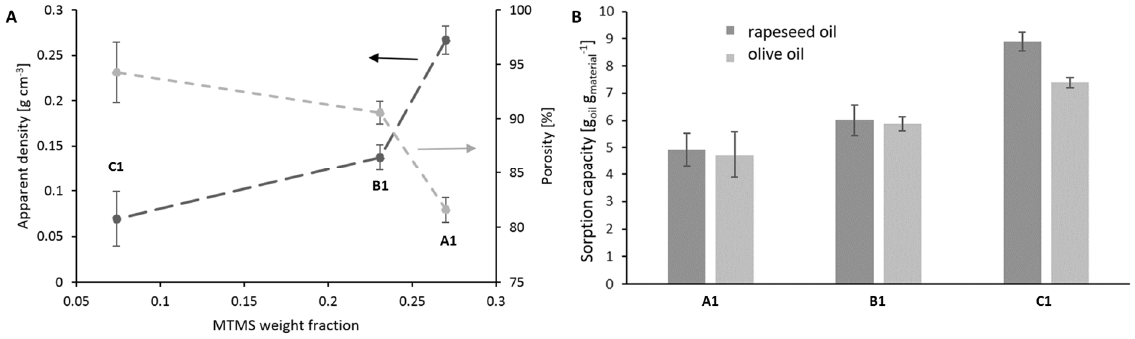
Figure 4. Used MTMS-based materials’ (synthesis A1–C1, as shown in Figure 2) apparent density (black line) and porosity (grey line) in the function of MTMS weight fraction ( A ), rapeseed oil, and olive oil sorption capacity of investigated gels ( B ).